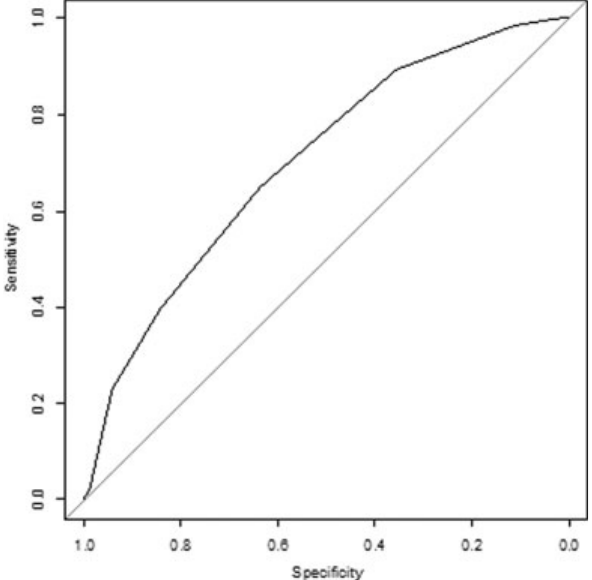
Fig. 1 VTE incidence according to the score and the thrombophilia status. The score is calculated on the basis of fi ve items: obesity accordingthe WHO de fi nition(BMI > 30 kg/m 2 ), smokingstatus, ABO blood group, F11 rs2036914, and FGG rs2066865.